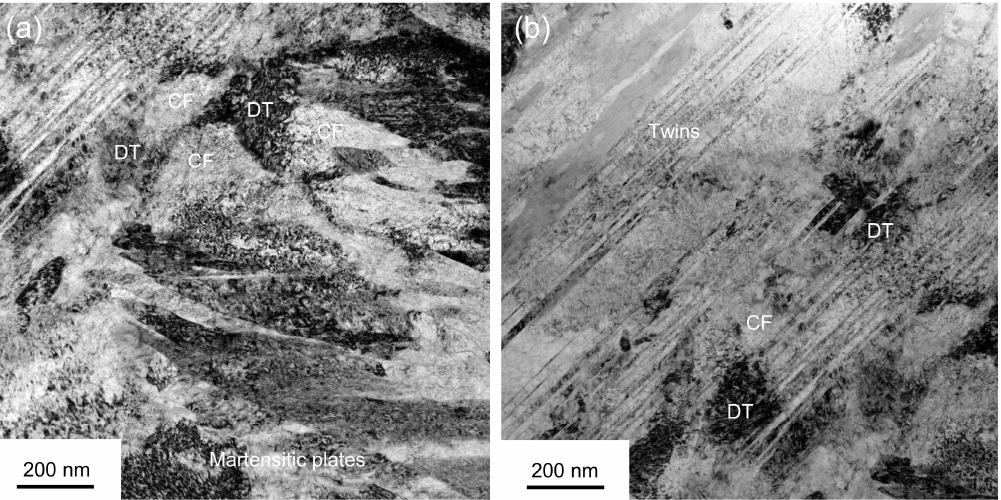
Figure 8. TEM micrographs of an area in the DER at a depth of 55 µm from the raceway surface in the RCF sample ( P 0 = 5 GPa, N = 2.12 × 10 8 cycles): ( a ) TEM micrograph of the transformed martensite plates; ( b ) TEM micrograph of the transformed twins.